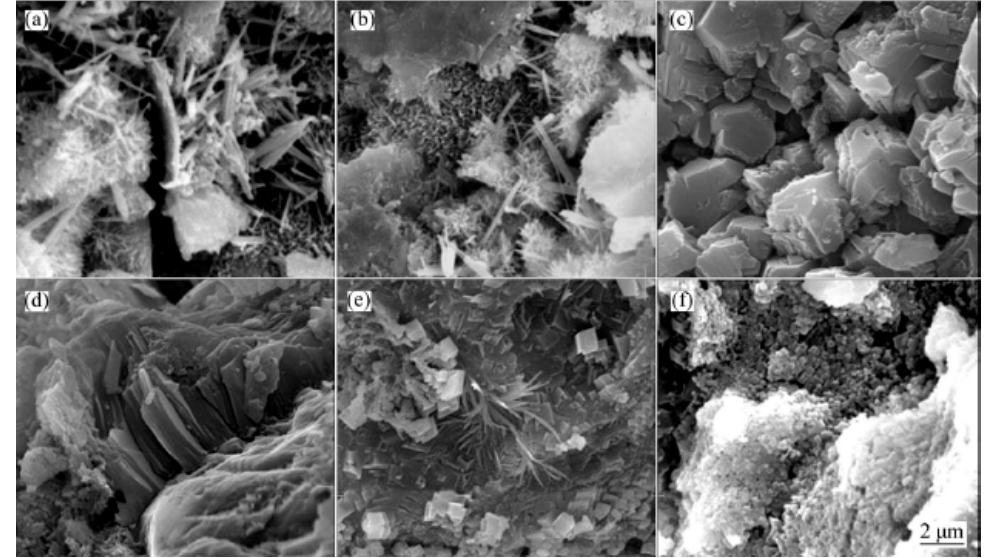
Figure 19. The effect of functionalized FGN to the cement composite after 28 days with varying FGN content ( a ) No FGN; ( b ) 0.01% FGN; ( c ) 0.02% FGN; ( d ) 0.03% FGN; ( e ) 0.04 % FGN and ( f ) 0.05% FGN. Same scale bar was used in ( a – f ). Reproduced with permission from [117], Springer, 2016.